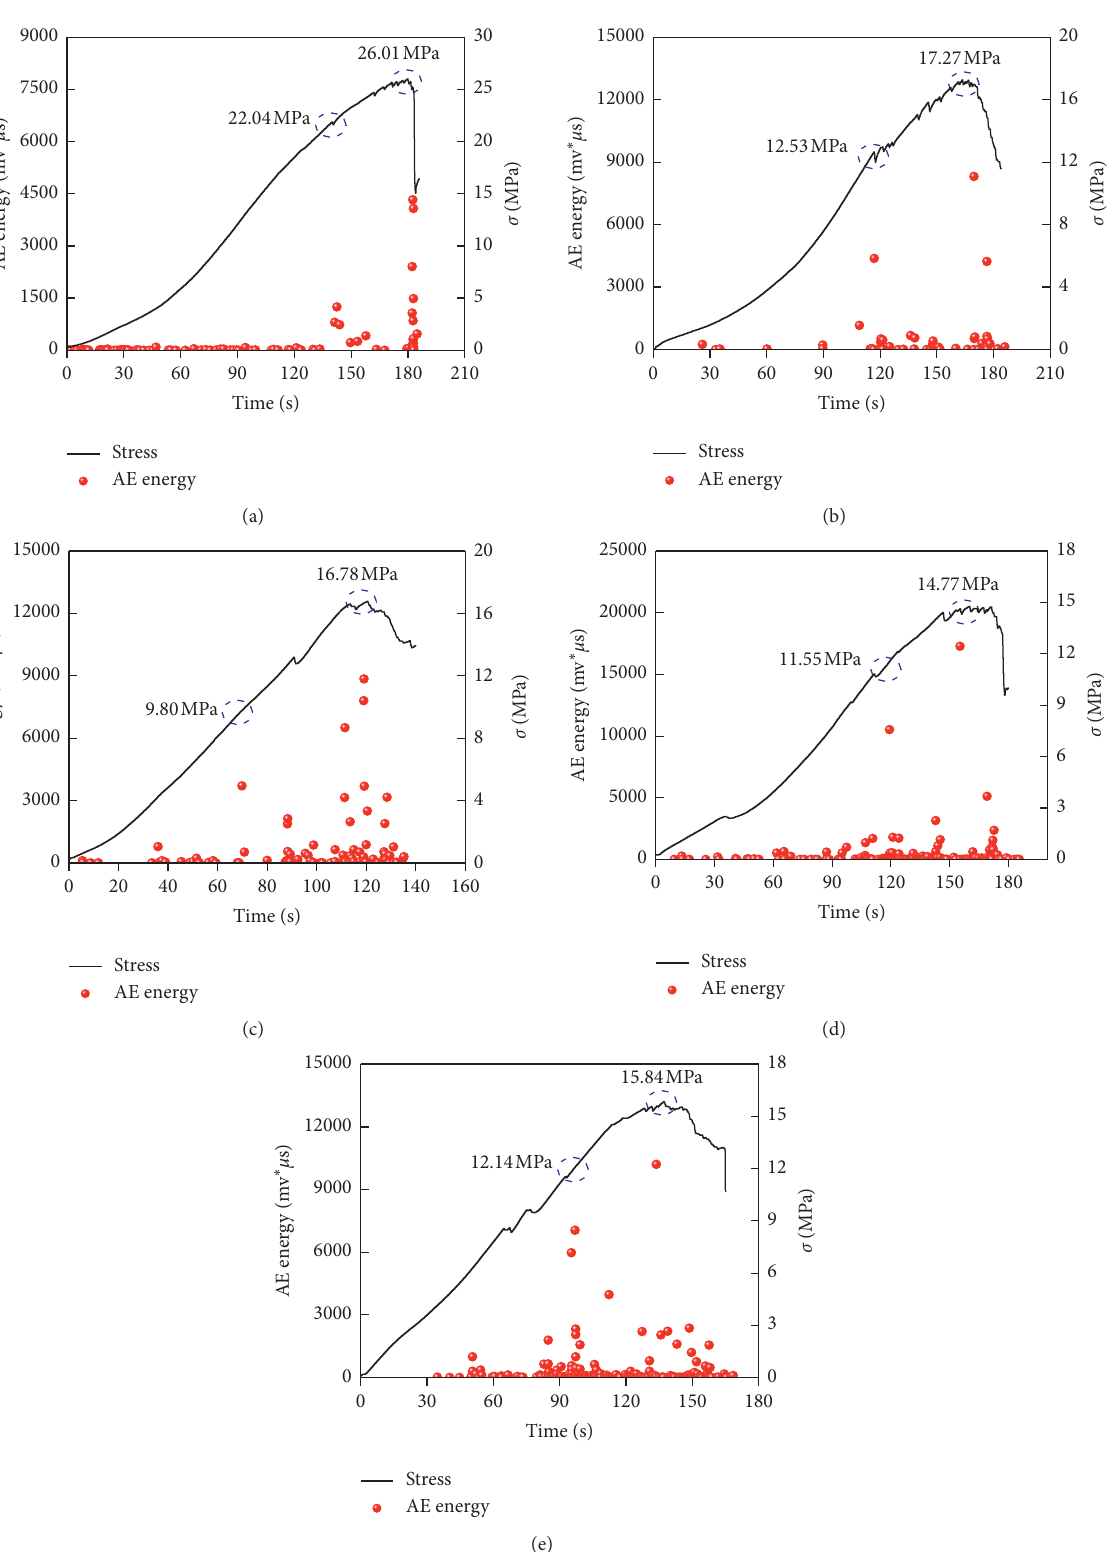
Figure 3: Evolution characteristics of AE energy with stress: (a) α � 0 ° ; (b) α � 30 ° ; (c) α � 45 ° ; (d) α � 60 ° ; (e) α � 90 °